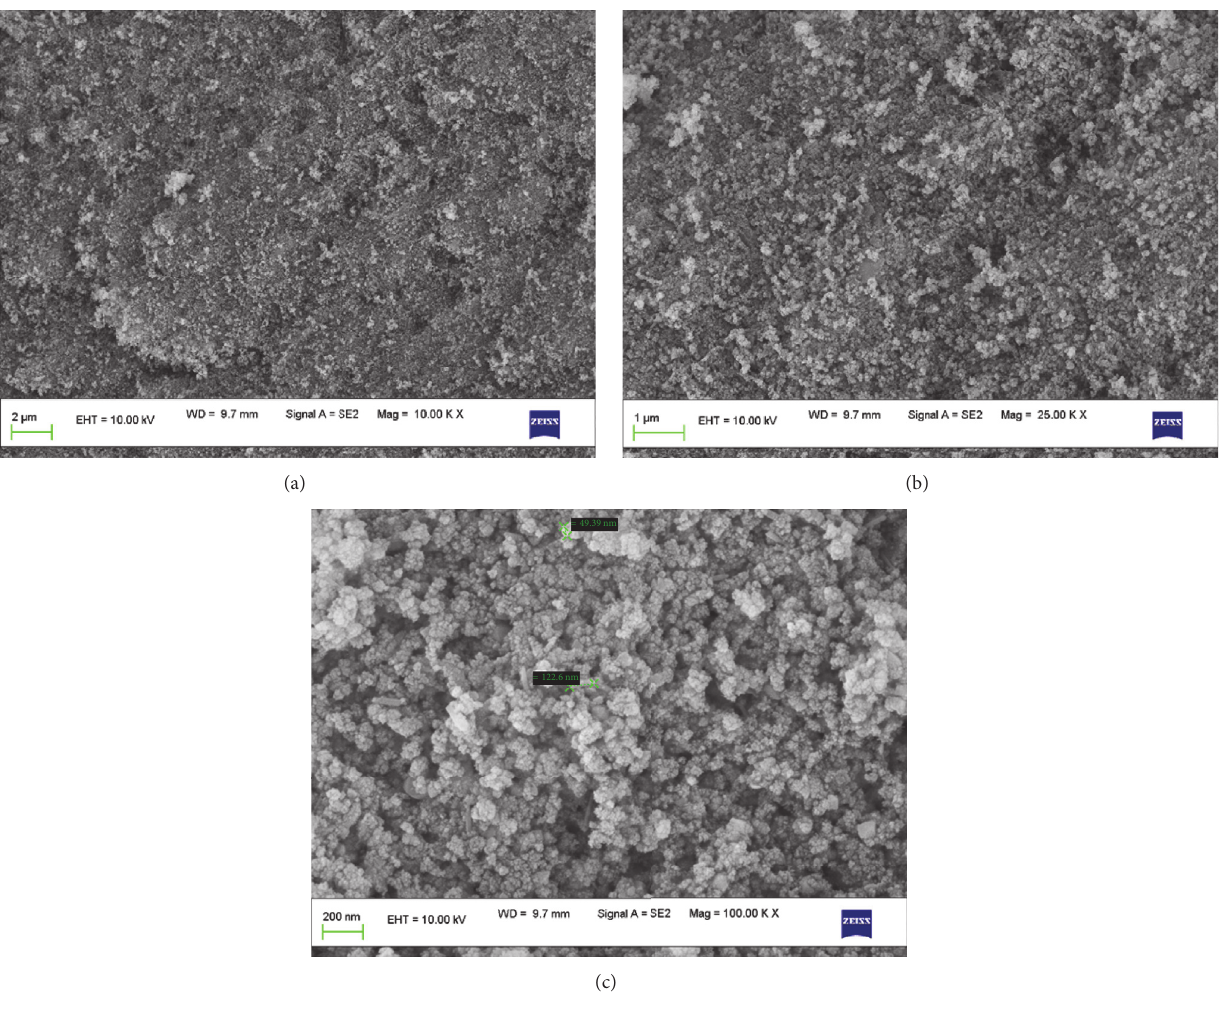
Figure 6: SEM images of as-prepared copper oxide nanoparticles.